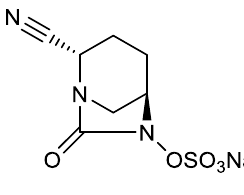
Figure 16. Chemical structure of diazabicyclooctane nitrile.